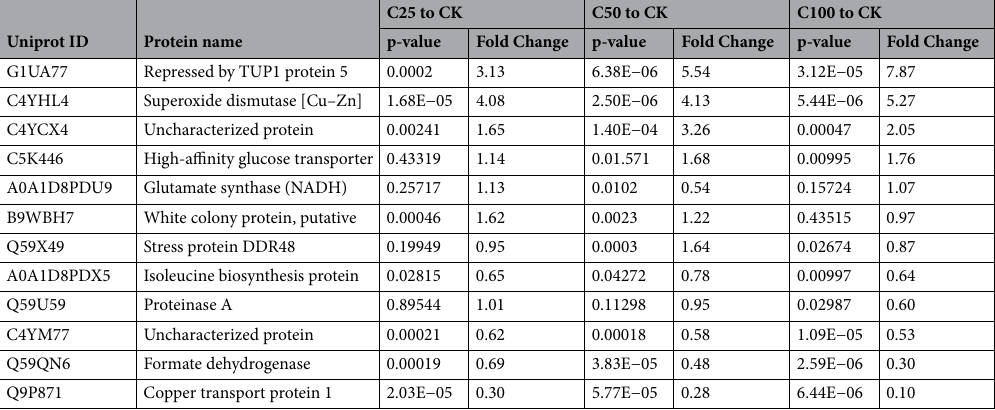
Table 2. Proteins with statistically significant changes in concentrations in response to the presence of different concentrations of the AAF fraction with an over 1.5-fold change in at least one